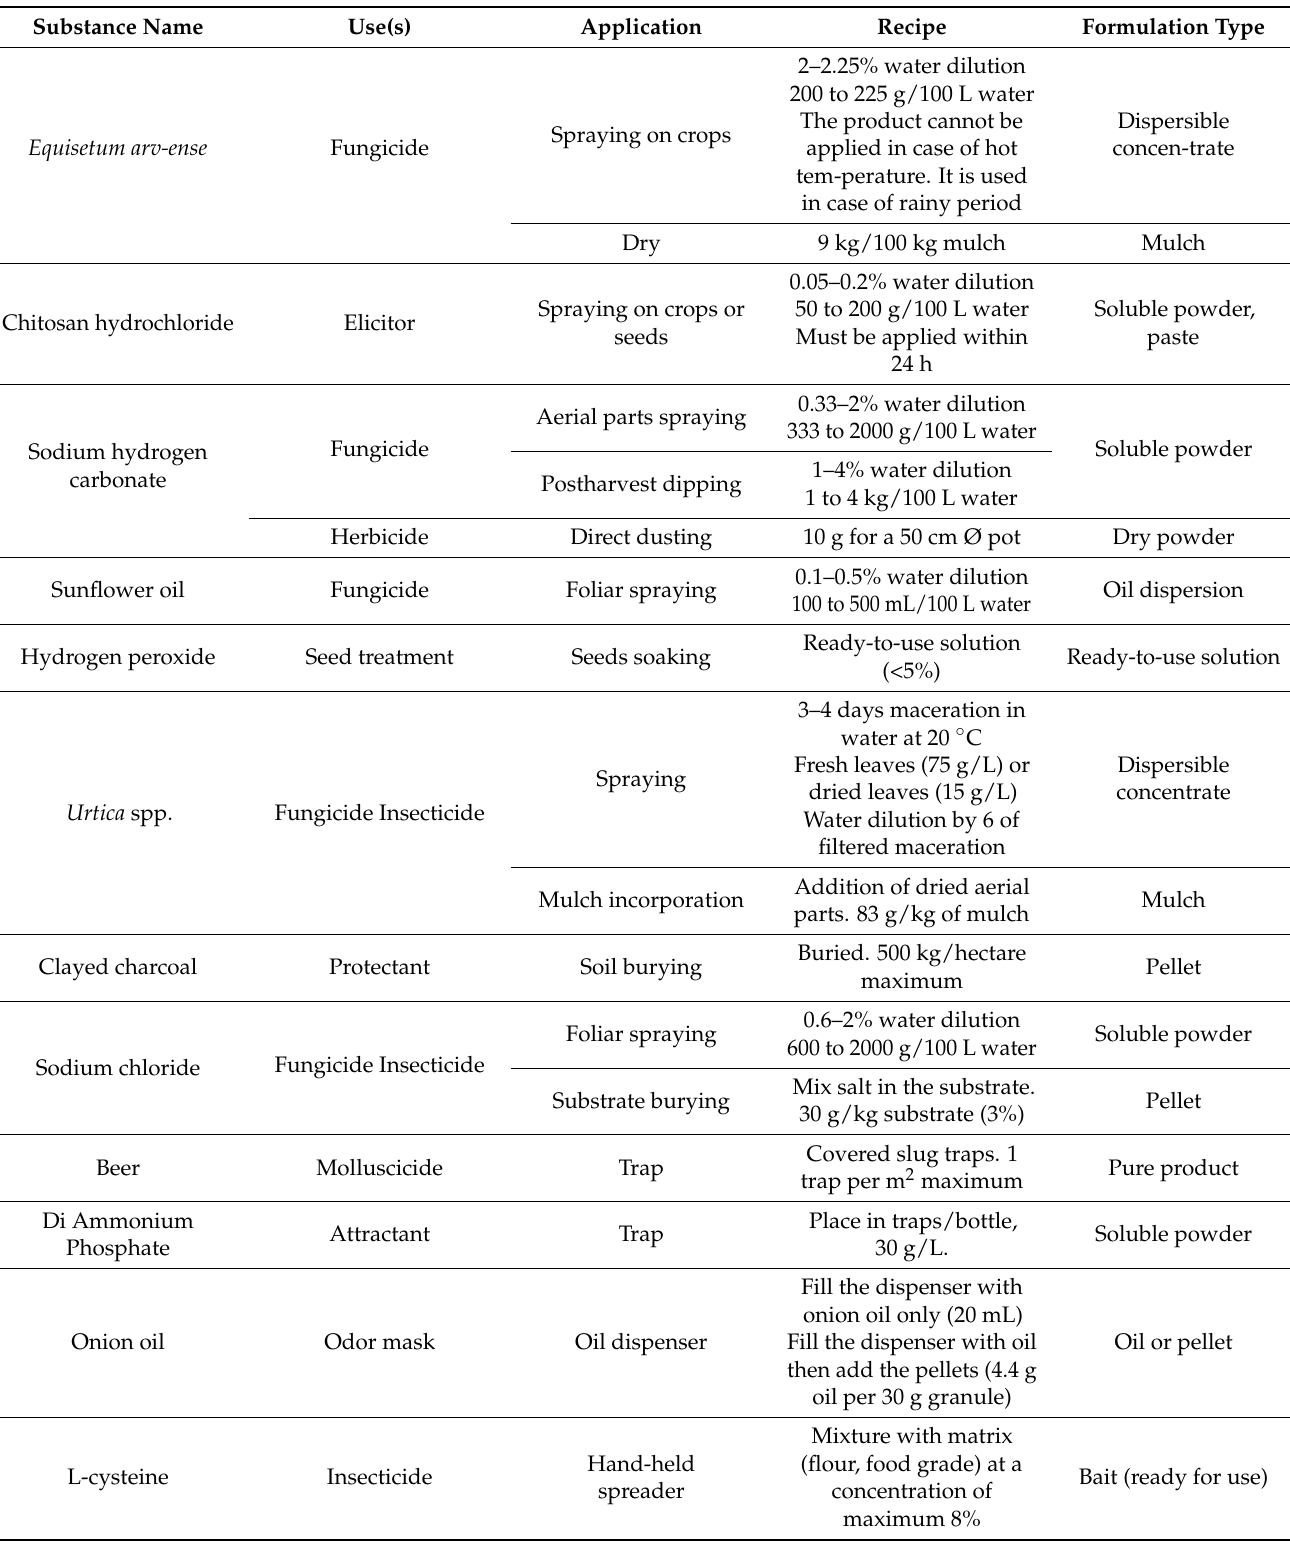
Table 2. Typical uses of the basic